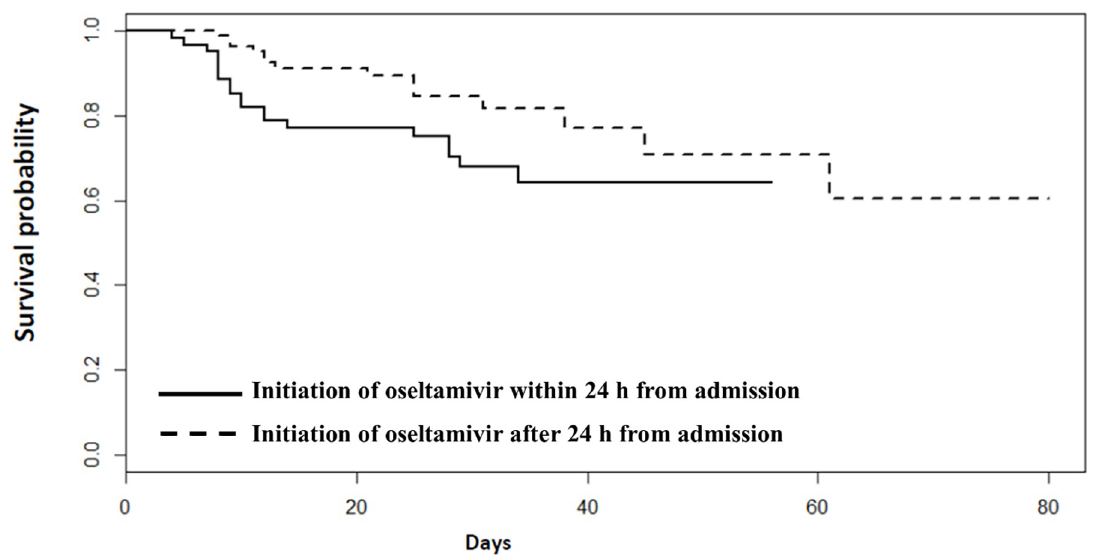
Fig 2. Survival between patients with community-acquired influenza pneumonia who received oseltamivir within 24 h from admission and those who received after 24 h from admission.